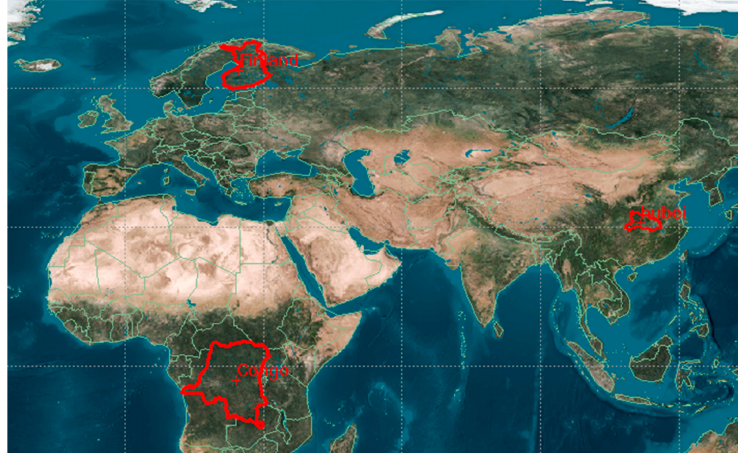
Figure 6. Distribution of target